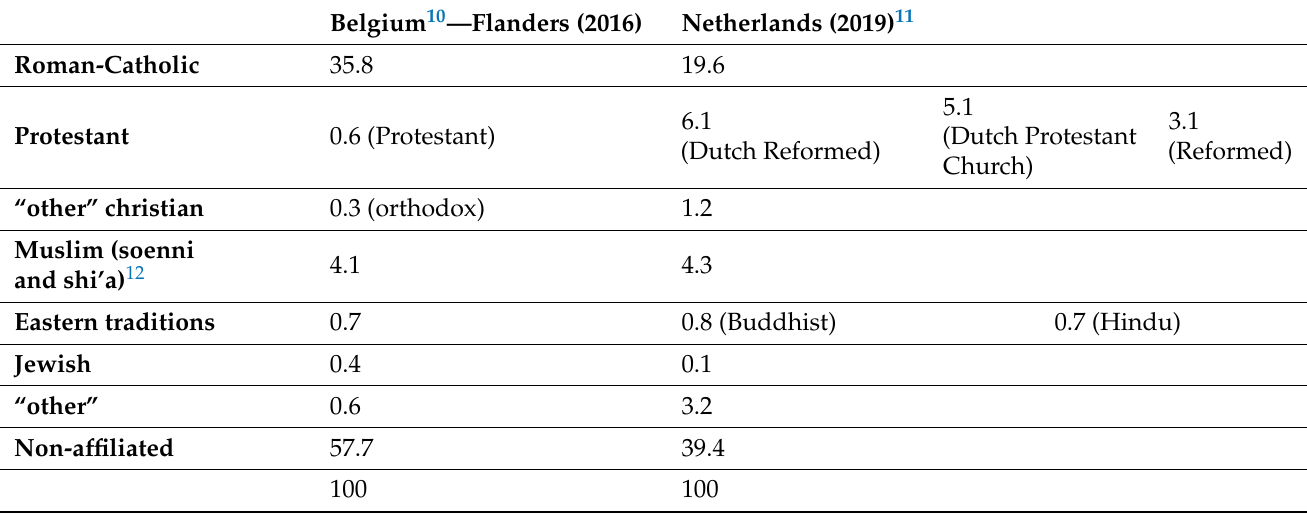
Table 1. Religious Affiliation in Belgium (Flanders) and in the